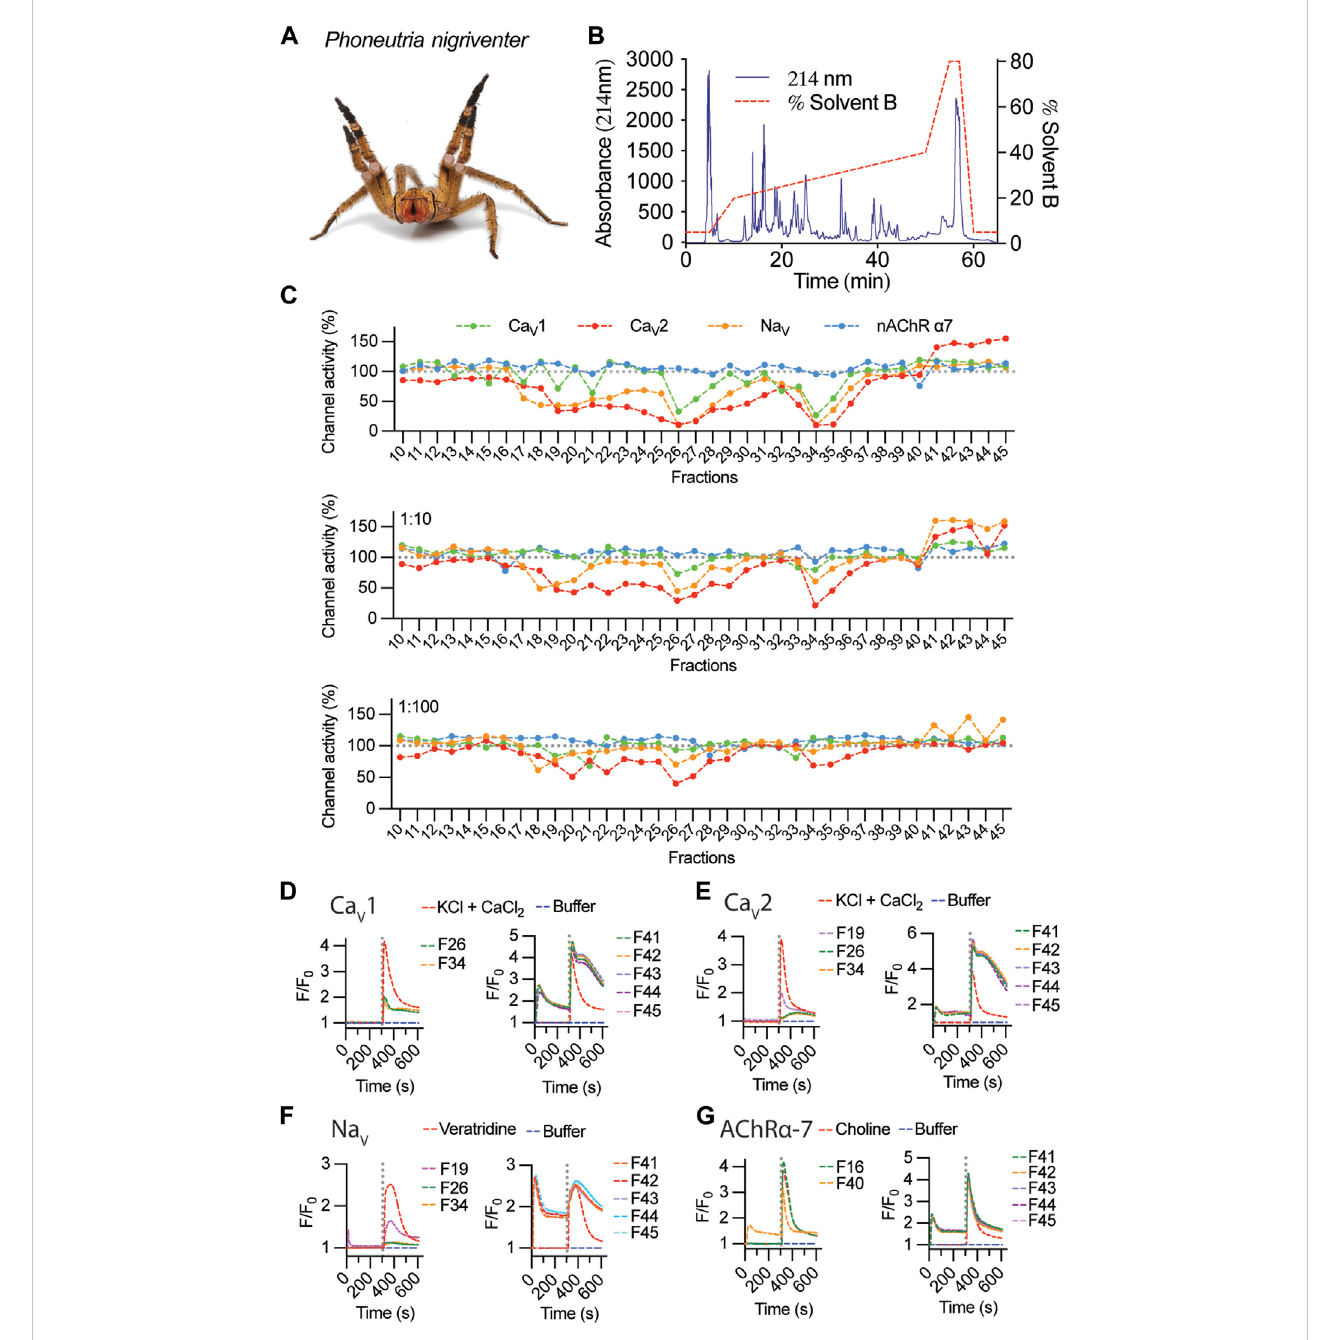
FIGURE 2 Fractionation and activity of P. nigriventer venom. (A) P. nigriventer specimen displaying threat posture (photo copyright Alan Henderson, www. minibeastwildlife.com.au). (B) RP-HPLC fractionationof1 mg P.nigriventer venom. (C) Ionchannelresponsescalculatedfromtheareaunderthecurve(AUC) after addition of selective activators for fractions 10 to 45, normalized to responses in the absence of venom fractions. (D, E) Representative fl uorescence traces oftheintracellular calciumresponses ofSH-SY5Ycells evoked byKCl+ CaCl 2 inthepresenceofvenom fractions26and34for Ca V 1,fractions